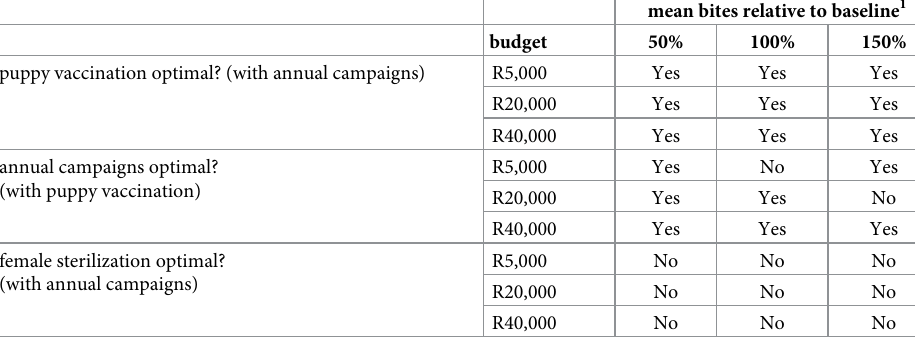
Table 7. Sensitivity of results to alternative mean bites per rabid